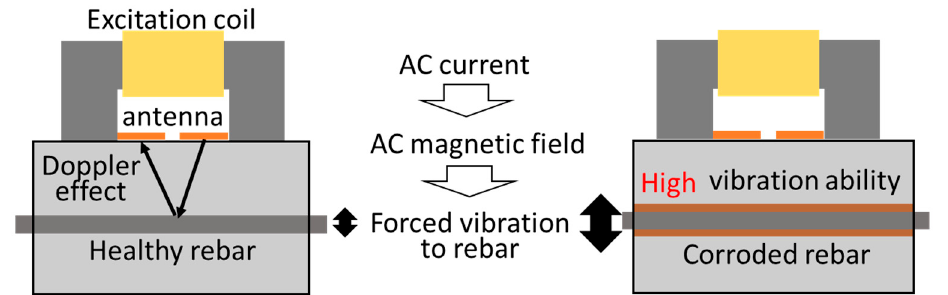
Figure 1. Concept of vibro-Doppler radar.